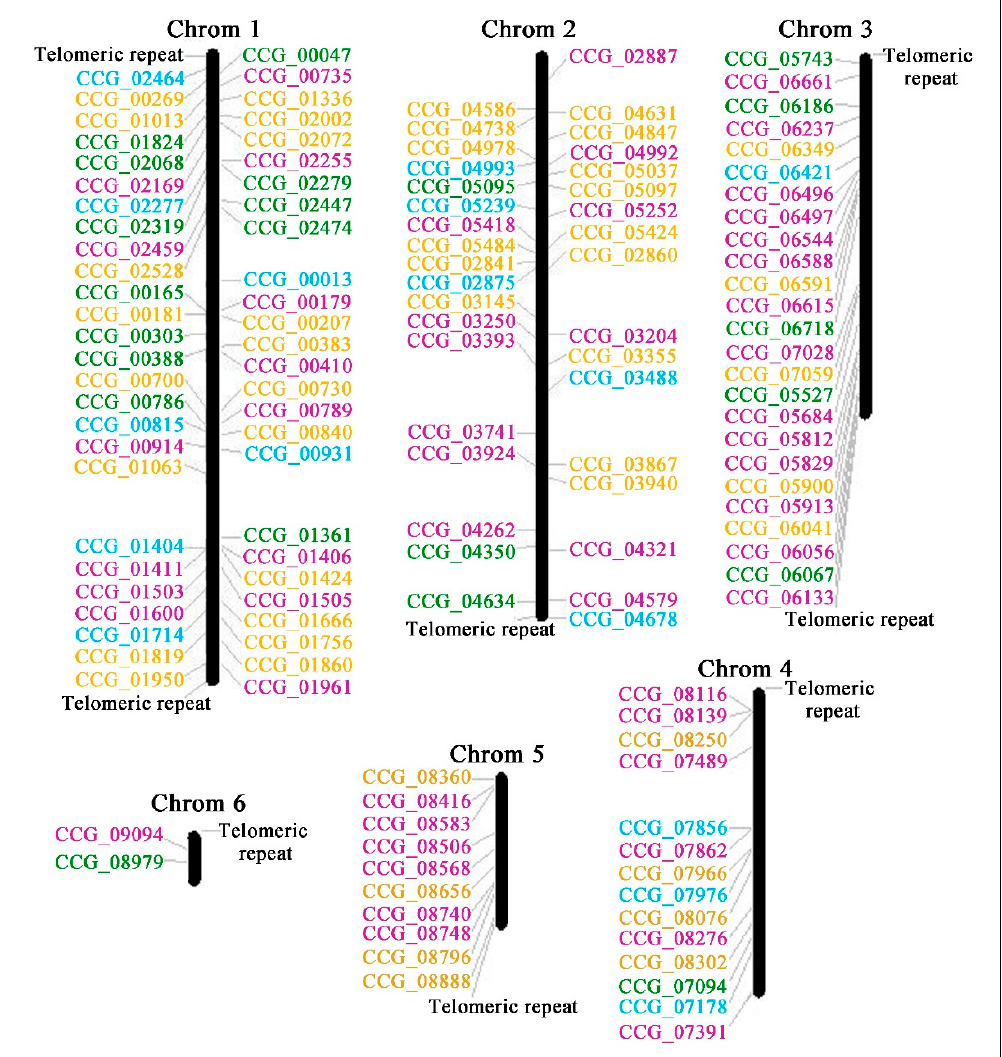
Figure 3. Genomic distribution of C6 zinc domain genes in T. guangdongense . 139 genes are located on six chromosomes. The numbers at the right side of the chromosomal bar indicate the names of C6 zinc domain genes and the corresponding position on the chromosome (megabase pairs; Mb) are given in Table S4. The “SM000906” type genes are represented in pink, “PF04082” type genes are in blue, “PF11951” type genes are in green and other “SM00066” type genes are in yellow color.